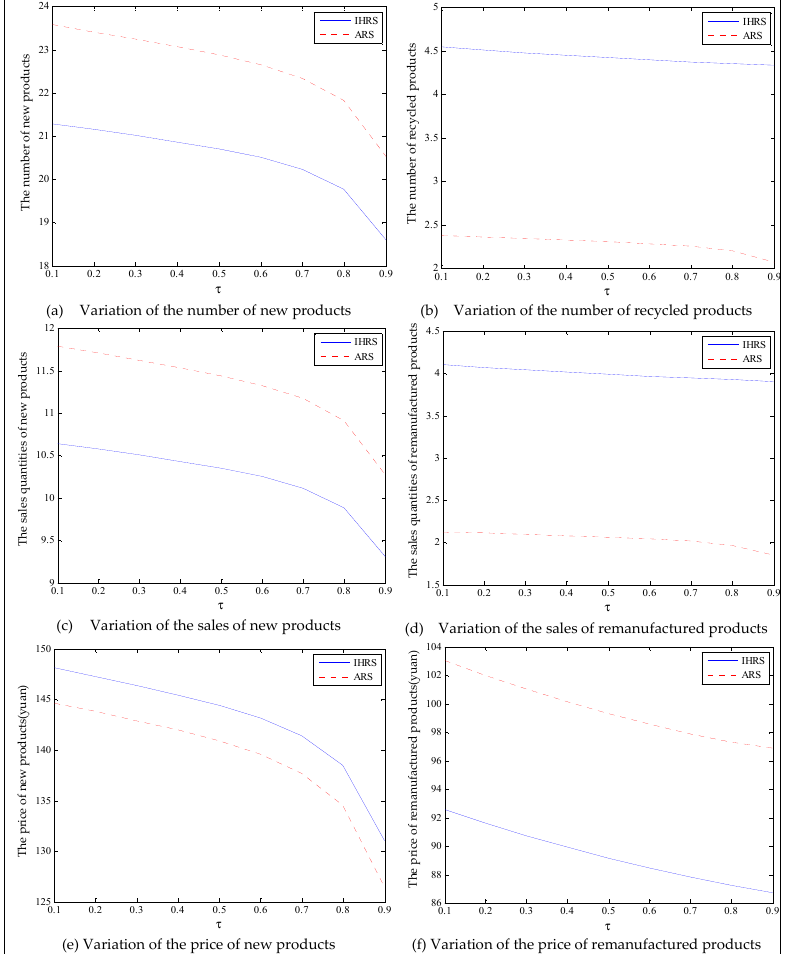
Figure 19. The variation of equilibrium strategies in Case 1 of Section 6.3.